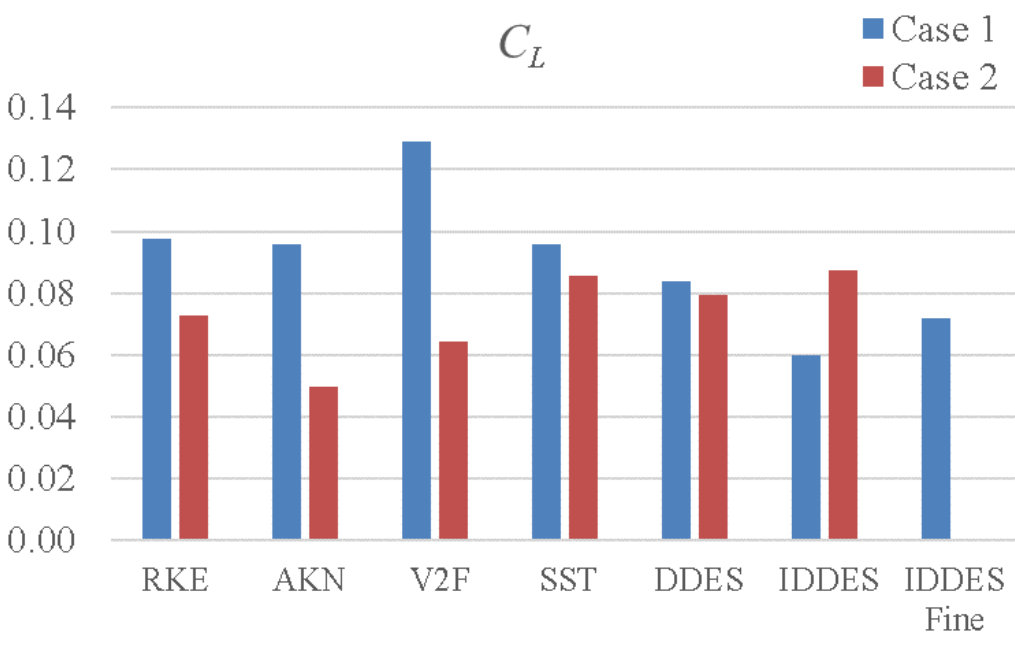
Figure 8. C L for both cases from the predictions of all turbulence models.